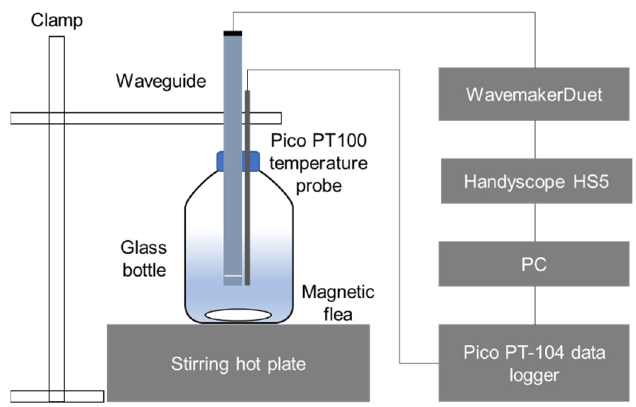
Figure 3. Schematic diagram of the experimental setup.